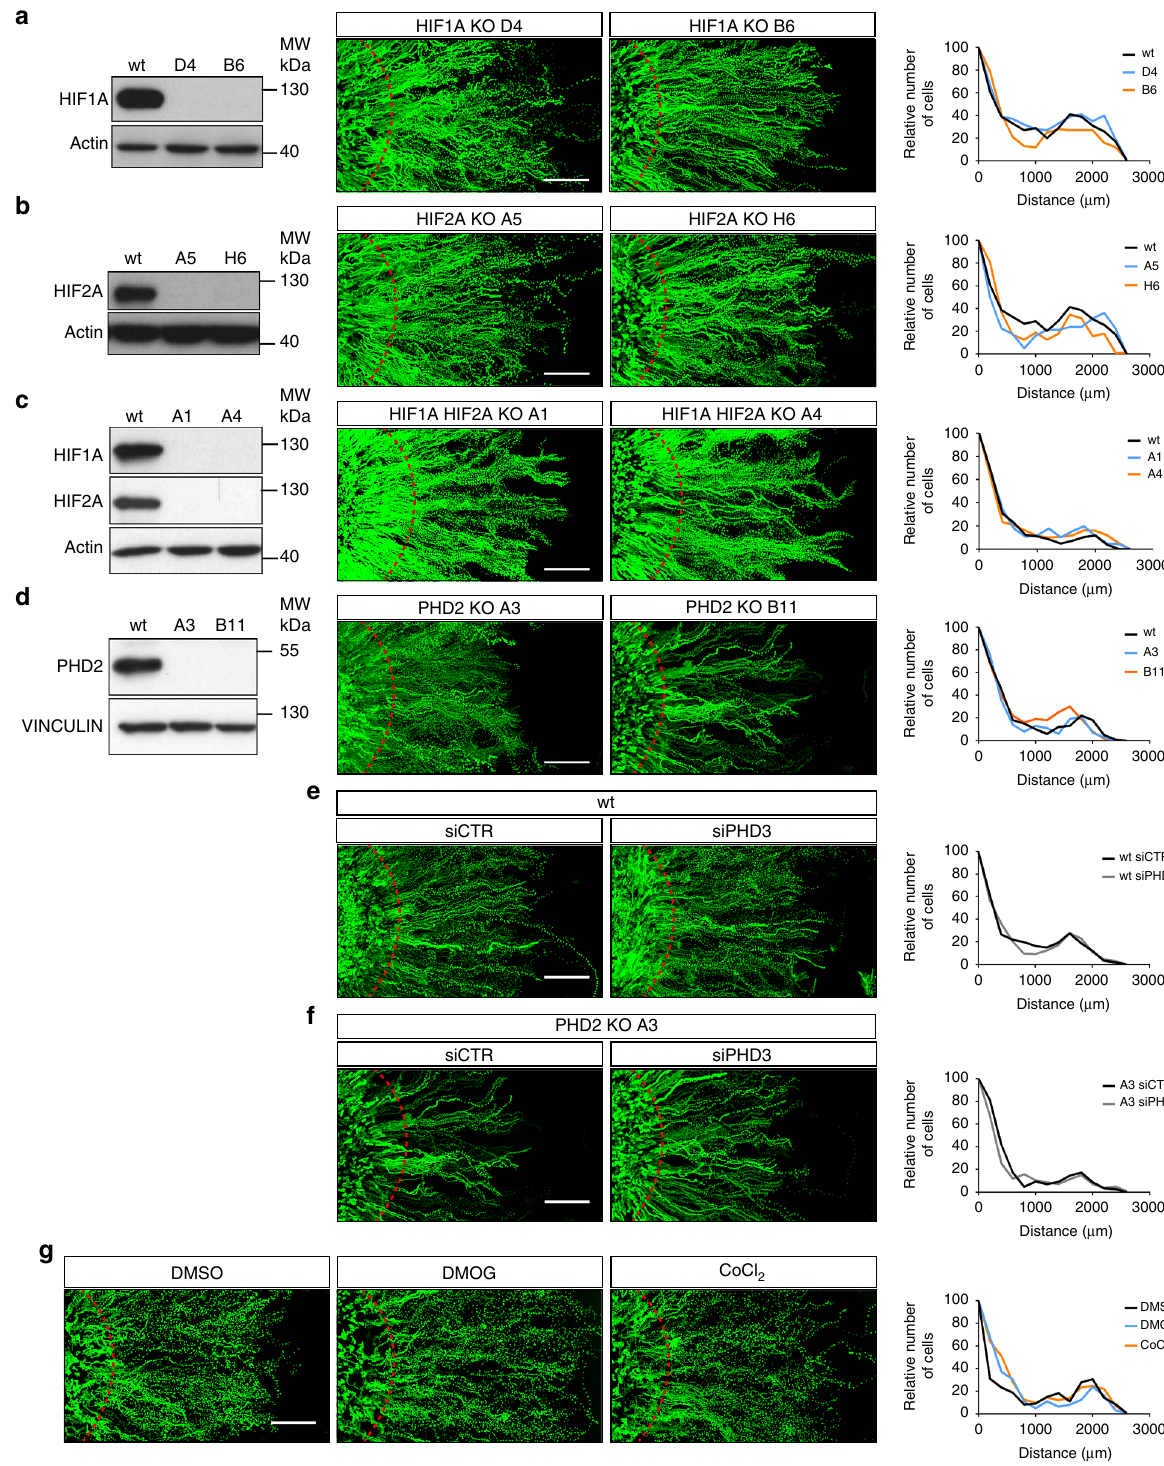
Fig. 3 Oxygen chemotaxis is independent of the PHD/HIF pathway. a – d HIF1A , HIF2A , HIF1A + HIF2A and PHD2 CRISPR/Cas9 KO clones characterisation, respectively, regarding O 2 -directed migration. Left panels: immunoblot validation of HIF1A , HIF2A , HIF1A + HIF2A and PHD2 KO clones. To blot HIFs factors ( a , b , c ), cells were fi rst pre-treated for 5 h with CoCl 2 300 µ M before protein extraction, a condition that promotes HIF factors accumulation (cf. Supplementary Fig. 8f). Middle panels: cell trajectories under con fi nement. Red dashed lines indicate the border of the cell cluster at 0 h. Right panels: relative distribution of MCF10A KO clones versus wt cells at the edge of the cluster at 48 h. These experiments demonstrate that HIF factors deletion does not prevent aerotaxis. e , f Tracks and redistribution of wt and PHD2 KO clone silenced for PHD3 (siPHD3) or not (siCTR). g Tracks and redistribution of MCF10A cells treated with DMOG (50 µ M) or CoCl 2 (50 µ M) to inhibit PHDs, or with vehicle only (DMSO). These experiments demonstrate that PHDs do not participate in O 2 -sensing during aerotaxis. Con fi nement was applied for 48 h ( a – g ). Scale bars, 500 µ